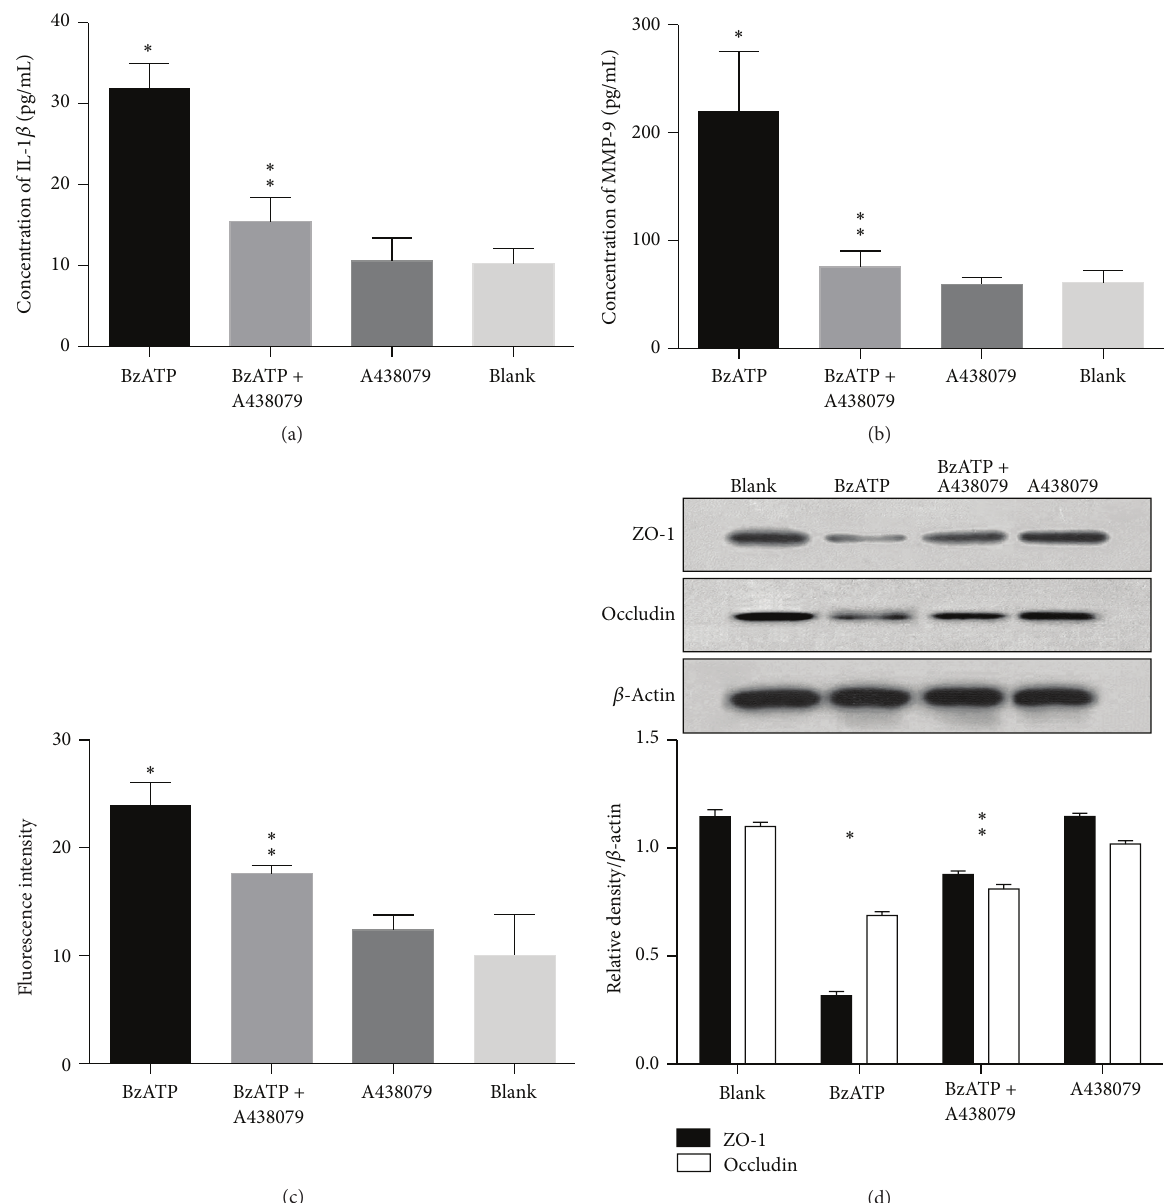
Figure 1: A438079 attenuates BzATP-induced disruption of blood-brain barrier in vitro. (a) The IL-1 𝛽 level was significantly higher in BzATP groups than in control groups ( ∗ 𝑃 < 0.05 ). A438079 treatment significantly reduced the levels of IL-1 𝛽 compared with the vehicle group ( ∗∗ 𝑃 < 0.05 ). (b) The level of MMP-9 was significantly higher in BzATP groups than in control groups ( ∗ 𝑃 < 0.05 ). A438079 treatment significantly reduced the level of MMP-9 compared with the vehicle group ( ∗∗ 𝑃 < 0.05 ). (c) BzATP induced hyperpermeability compared with the control groups ( ∗ 𝑃 < 0.05 ), which was decreased by the P2X7 inhibitor A438079 in the coculture system ( ∗∗ 𝑃 < 0.05 ). (d) Western blot analysis showed that the expression of ZO-1 and occludin in the BzATP groups was decreased compared with the controls ( ∗ 𝑃 < 0.05 ), while A438079 treatment significantly attenuated the disruptions of ZO-1 and occludin ( ∗∗ 𝑃 < 0.05